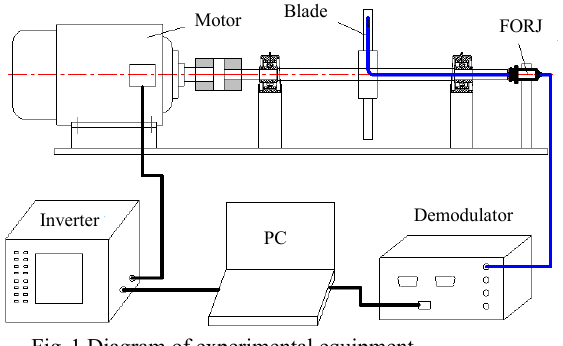
Fig. 1 Diagram of experimental